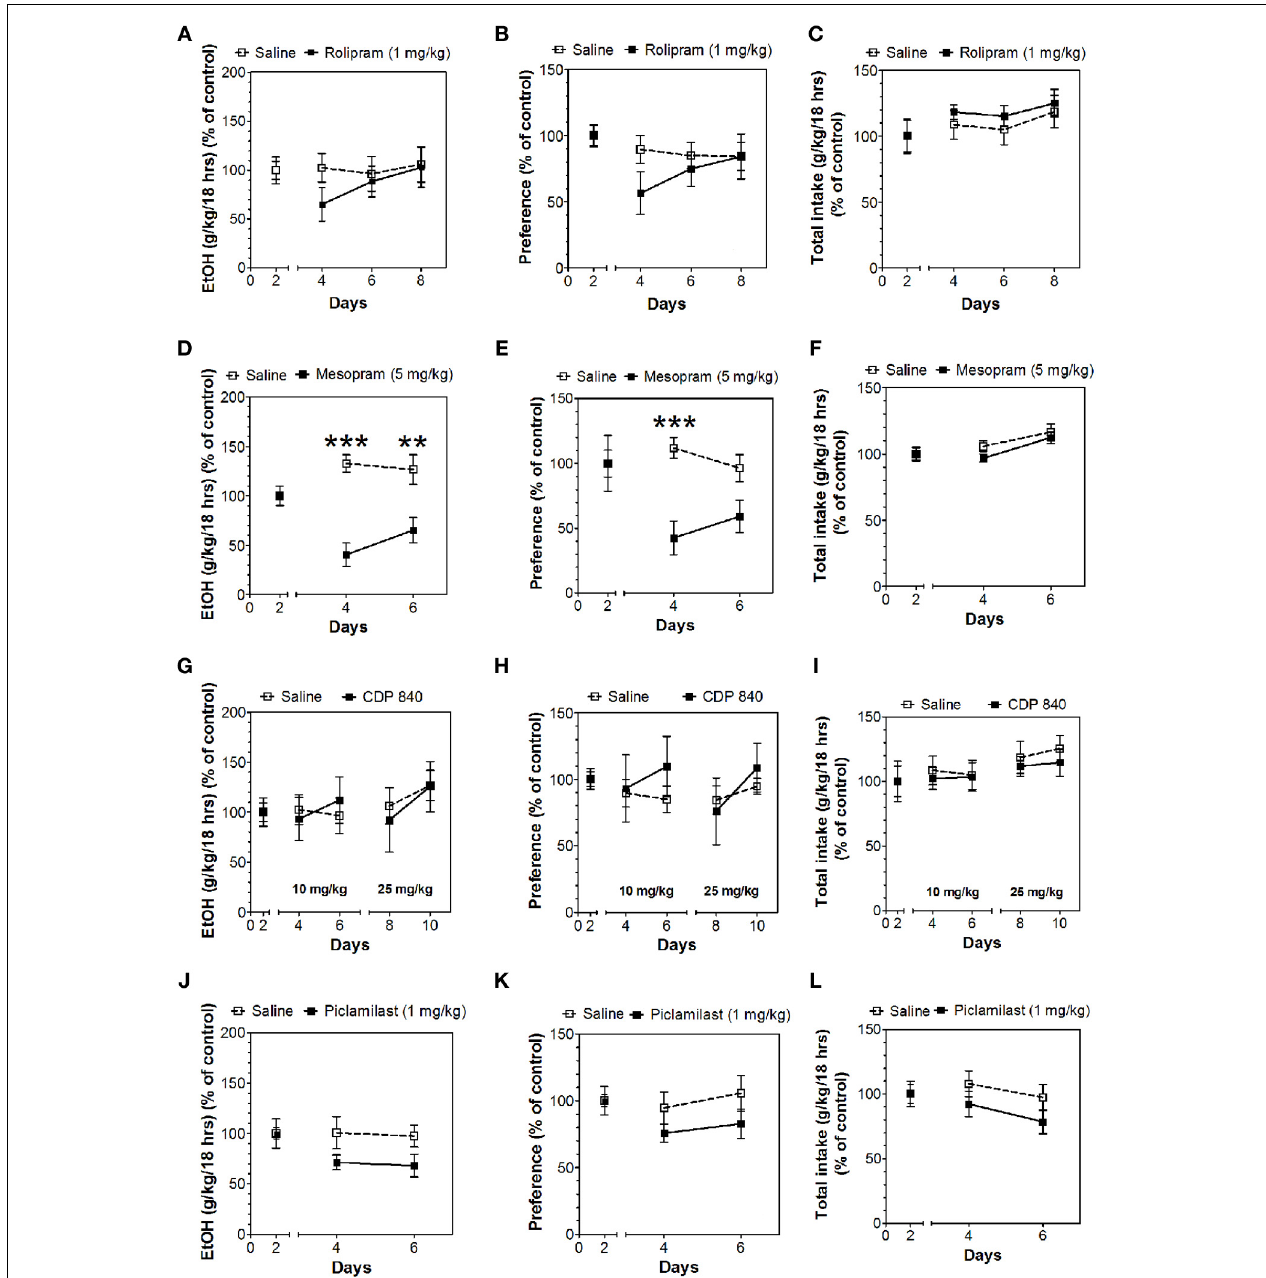
FIGURE 2 | Effects of PDE4 inhibitors on alcohol intake during the next 18h of the 24-h two-bottle choice paradigm. Ethanol consumption is presented as g/kg/18h: (A) Rolipram (D) Mesopram (G) CDP840 (J) Piclamilast.Preferenceforethanol: (B) Rolipram (E) Mesopram (H) CDP840 (K)